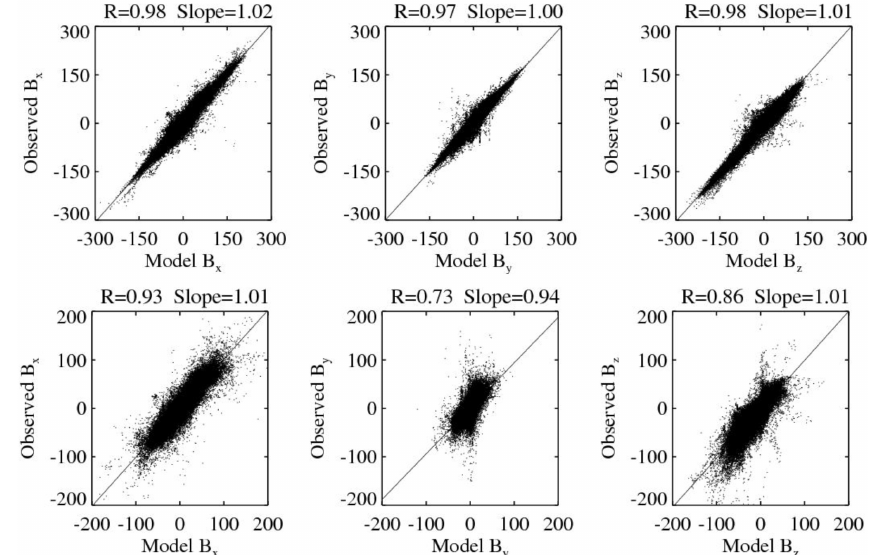
Fig. 14. Scatter plots of the model field components vs. the observed components, based on the data set shown in Fig. 12. Only data taken outside r = 6 . 6 R E are included. Plots in the top and bottom rows compare the components of the total and external parts of the field, respectively. The corresponding correlation coefficients and regression slopes are shown in each panel.